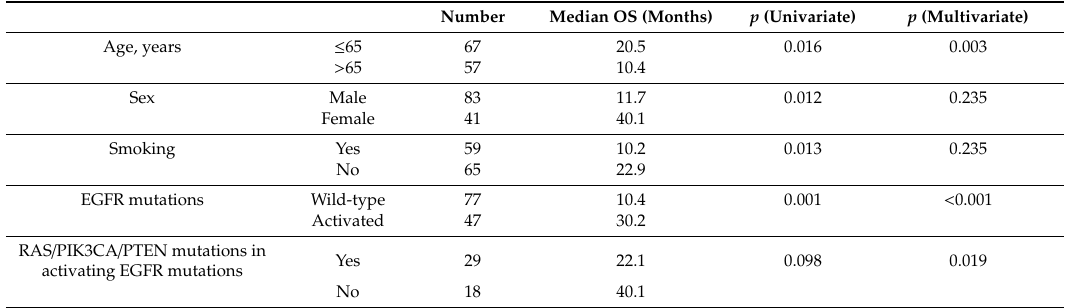
Table 4. Overall survival by clinical characteristics; RAS/PIK3CA/PTEN mutations are independent predictors of poor prognosis in patients with activating EGFR mutation.